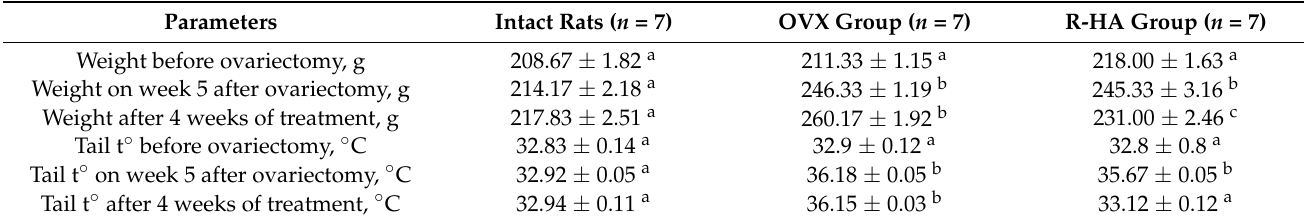
Table 1. Weight and tail temperature dynamics before and after treatment.